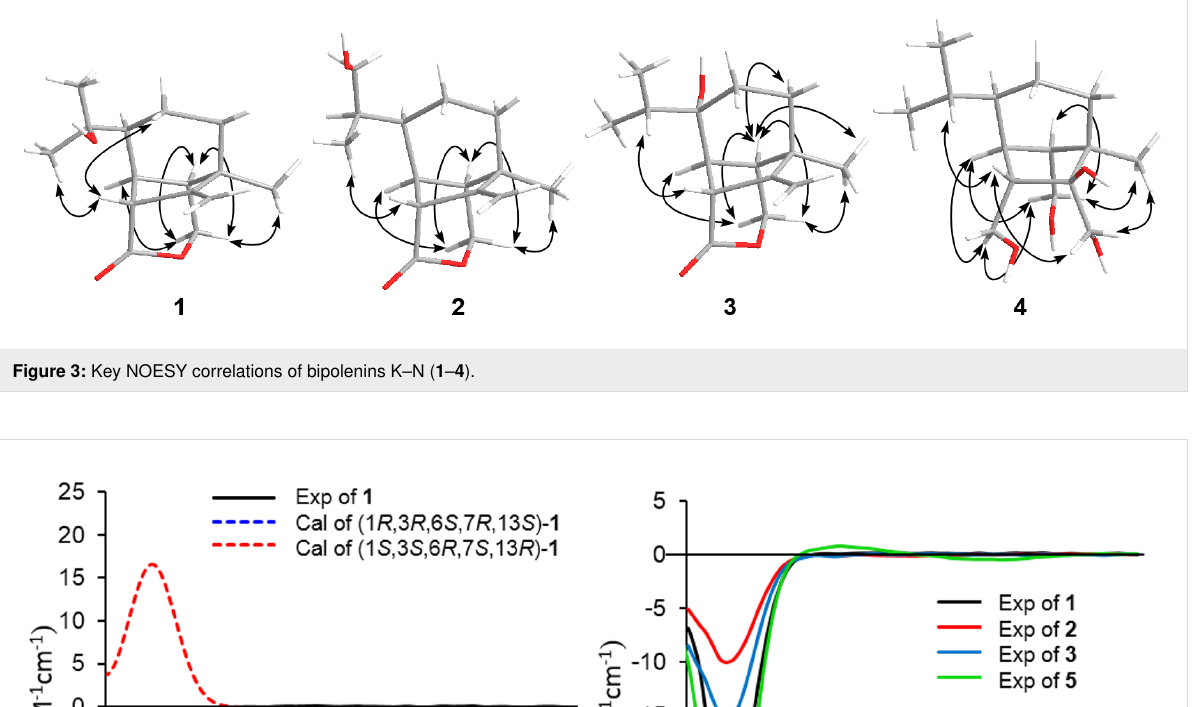
was not determined. Hence, structure 2 was determined as shown in Figure